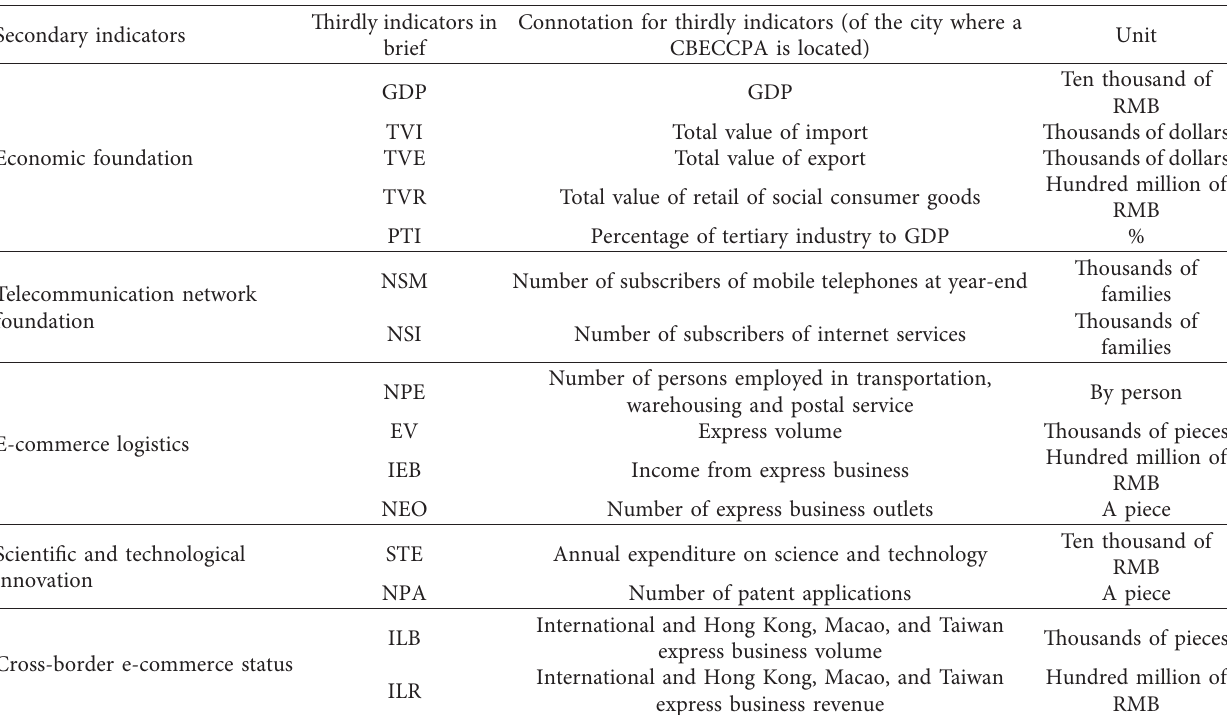
Figure 1: AMOS model for analyzing effects of CBECCPAs. Table 1: Summary and connotations of related